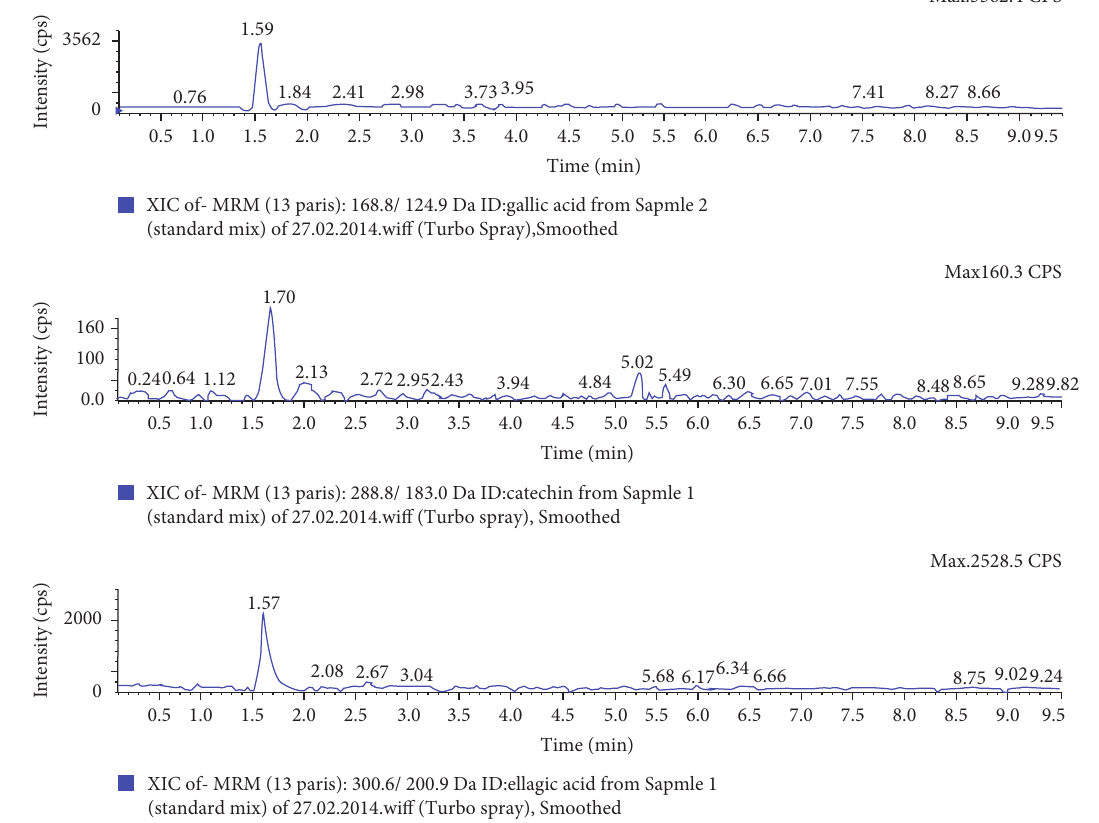
Figure 2: The XIC MRM chromatogram of the extracted tannins (from top to bottom, gallic acid, catechin, and ellagic acid). Table 4: (m/ z ) compound voltage dependent parameters